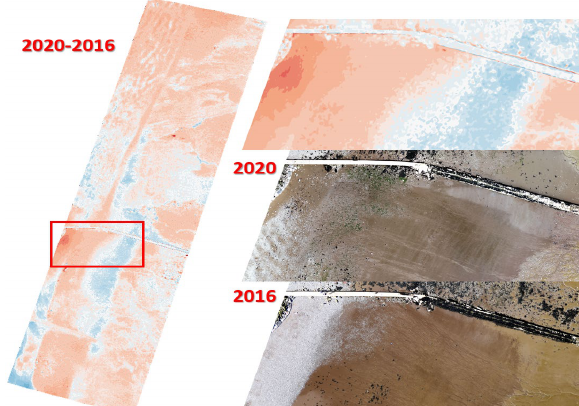
Figure 12 – Erosion/Accretion Map for the UAV Derived Models Between 2020 and 2016.